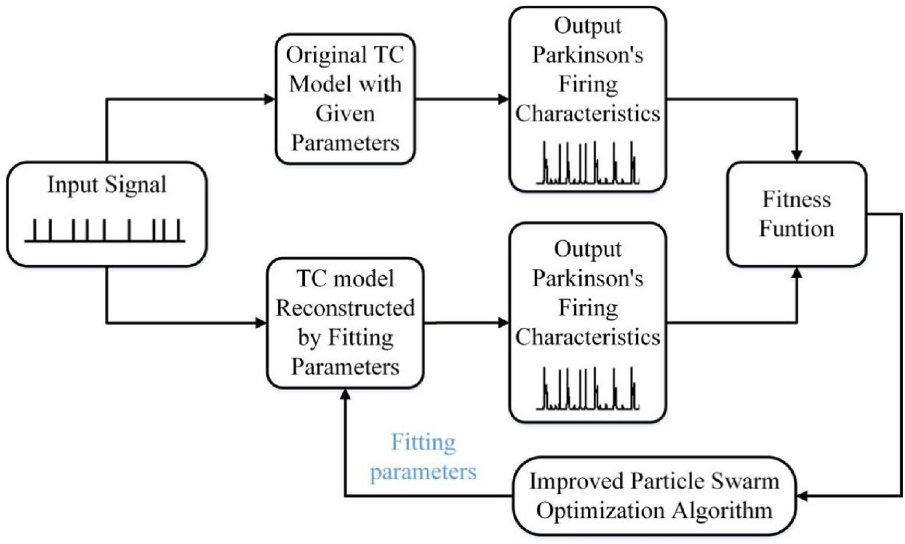
Figure 1. Fitting process of the TC model based on the improved particle swarm optimization